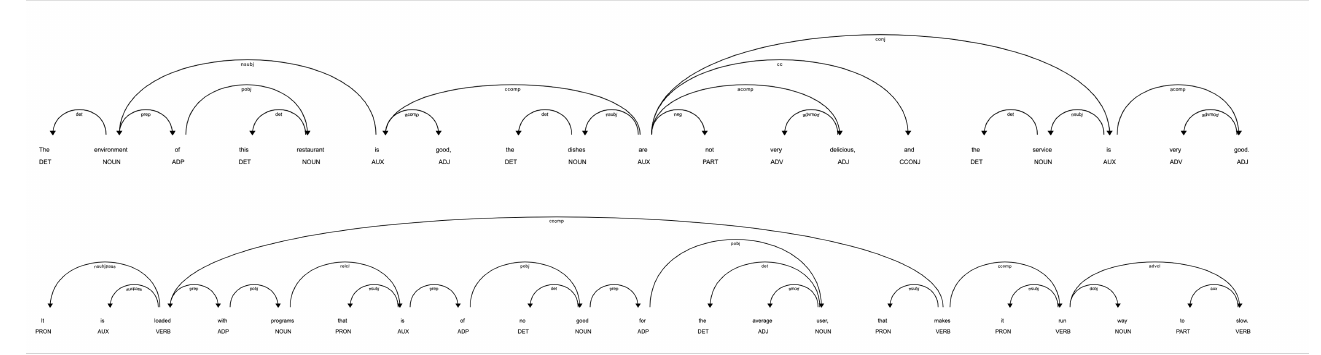
Figure 3. Dependency syntactic tree of the review